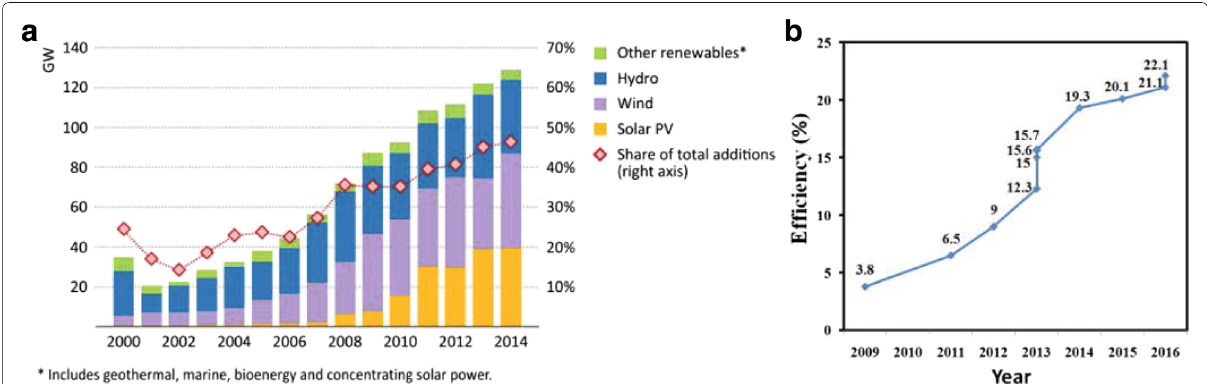
Fig. 1 a Global renewable-based power capacity additions by type and share of total capacity additions [60]. b Rapid PCE evolution of perovskite solar cells from 2009 to